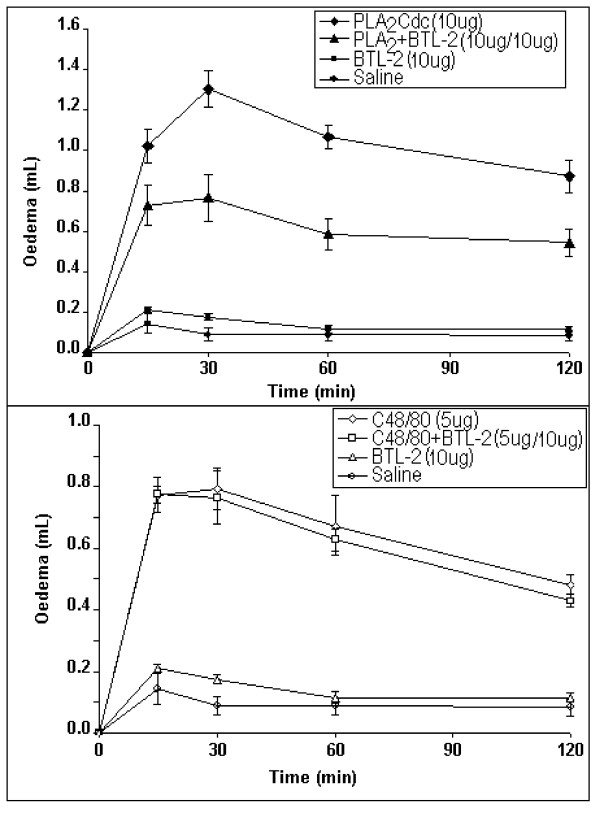
Male Wistar rats (120 g–150 g) were anaesthetised with halothane (inhaled). The paw oedema was induced by a single subplantar injection of 100 μL of sample 100 μg/paw). Paw volume was measured immediately before the injection and the intervals thereafter (15, 30, 60 and 120 minutes) using a hydroplethysmometer (model 7150, Ugo Basile, Italy). 7a) BTL-2 induced similar oedema simihat of the saline control. PLA2 showed the highest oedema at 30 minutes before the injection. The presence of BTL-2 decreased the oedema induced by the enzyme. 7b) The compound 48/80 (C48/80) was used, incubated with BTL-2, to show that the lectin was not acting on the tissues to decrease the action of PLA2, but was probably binding to the enzyme. Thus, the lectin did not decrease the action of C48/80 act.